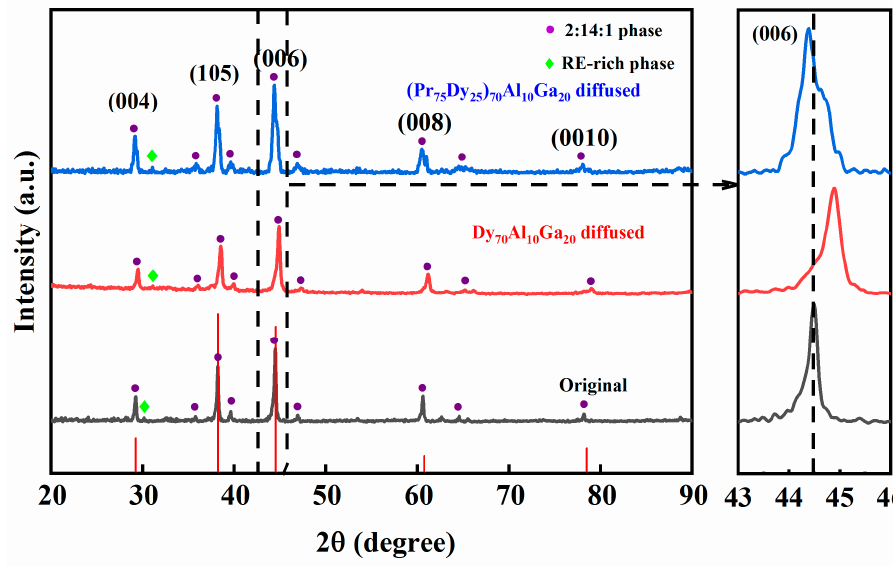
Figure 4. XRD patterns of the original magnet, and Dy 70 Al 10 Ga 20 and (Pr 75 Dy 25 ) 70 Al 10 Ga 20 alloy diffused magnets (the surface of observation is the near-surface).